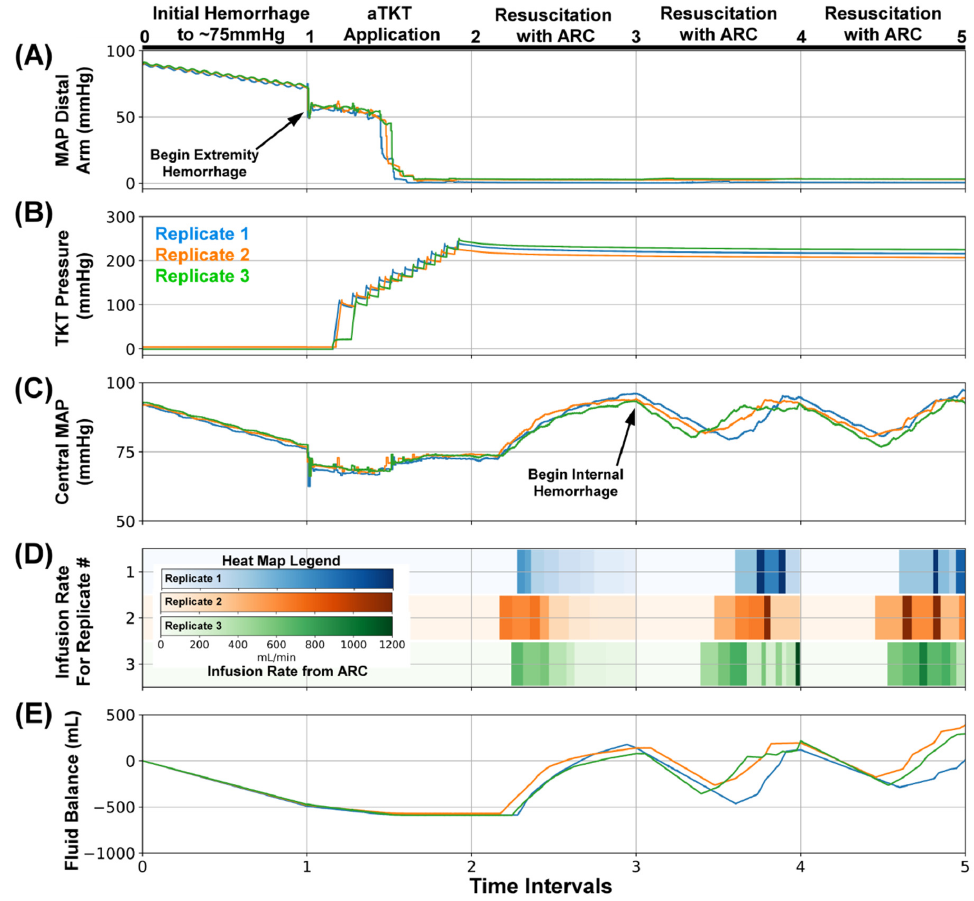
Figure 7. SACM Testing Scenario #3. After (0–1), the initial hemorrhage reduced blood pressure to approximately 75 mmHg, (1–2) extremity hemorrhage was stopped by aTKT, (2–3) and